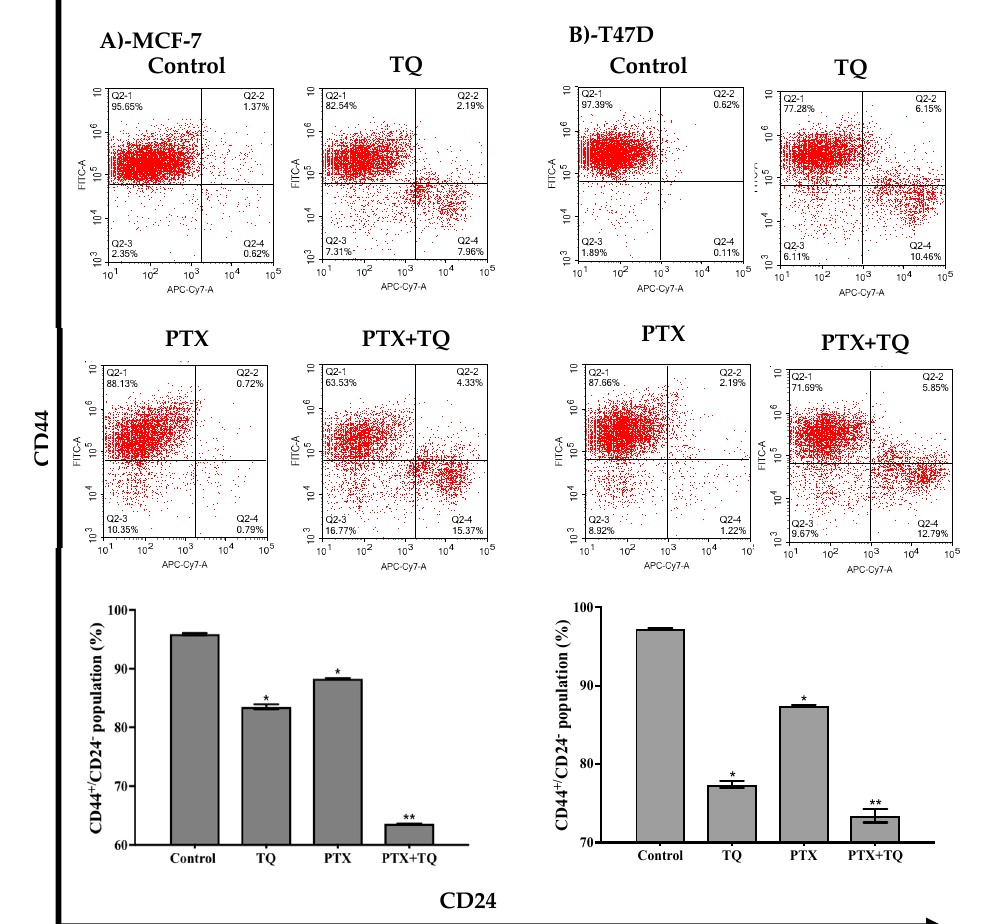
Figure 6. Effect of PTX, TQ, and their combination on the expression of CD44 and CD24 stem cell markers. MCF-7 ( A ) and T47D ( B ) cells were exposed to PTX, TQ, or their combination for 24 h. Expression levels of CD44 and CD24 were assessed using flowcytometry and plotted as percentage of total events. Data are presented as mean ± SD; n = 3. (*) significantly different from the control group. (**) significantly different from PTX treatment.